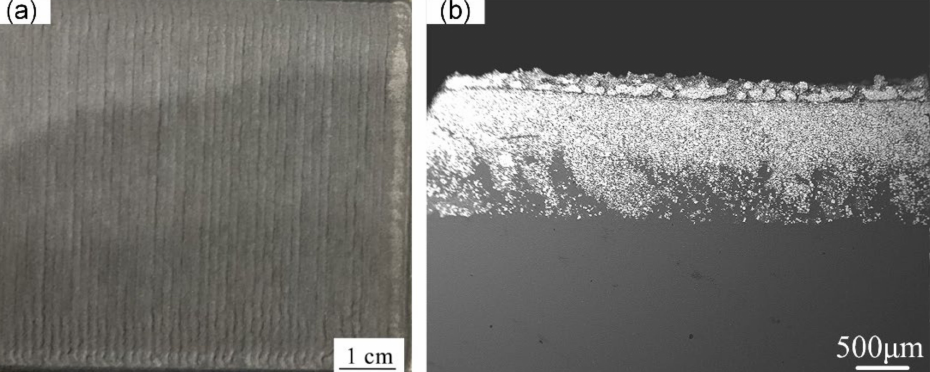
Figure 4. Macroscopic surface ( a ) and cross-section ( b ) of the W/Al composite layer with a powder feeding rate of 16 g/min.